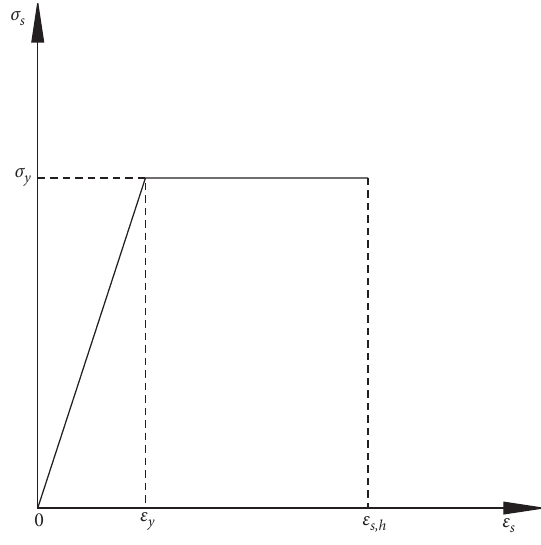
Figure 1: Stress-strain curve of steel bar.